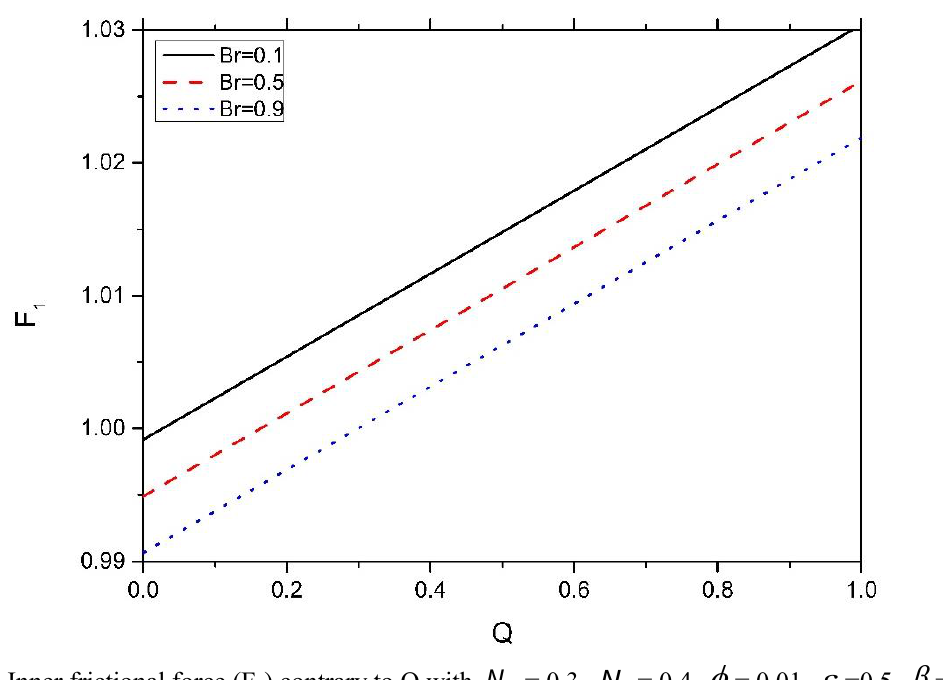
Fig. 6(b). Inner frictional force (F 1 ) contrary to Q with